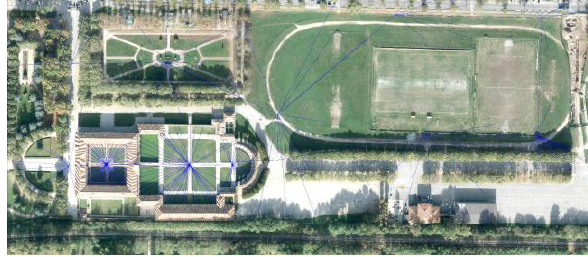
Figure 1. Aerial ortophoto with the 13 topographic